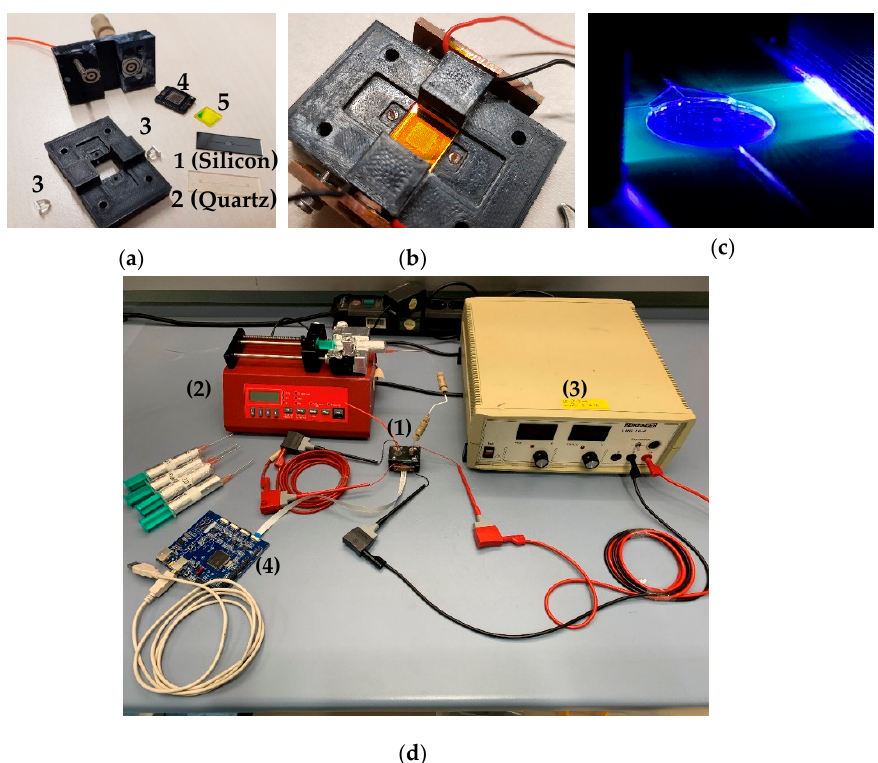
Figure 4. ( a ) Exploded view of the detection system before assemblage: (1) silicon fluidic cell; (2) quartz fluidic cell; (3) 420 nm light emitting diodes (LEDs); (4) CMOS image sensor; (5) band pass filter. ( b ) Assembled device;.( c ) Light transmission through the fluidic cell towards the detection chamber. ( d ) (1) Experimental setup: assembled device, (2) syringe pump, (3) 24 V DC power supply, (4) microcontroller board.